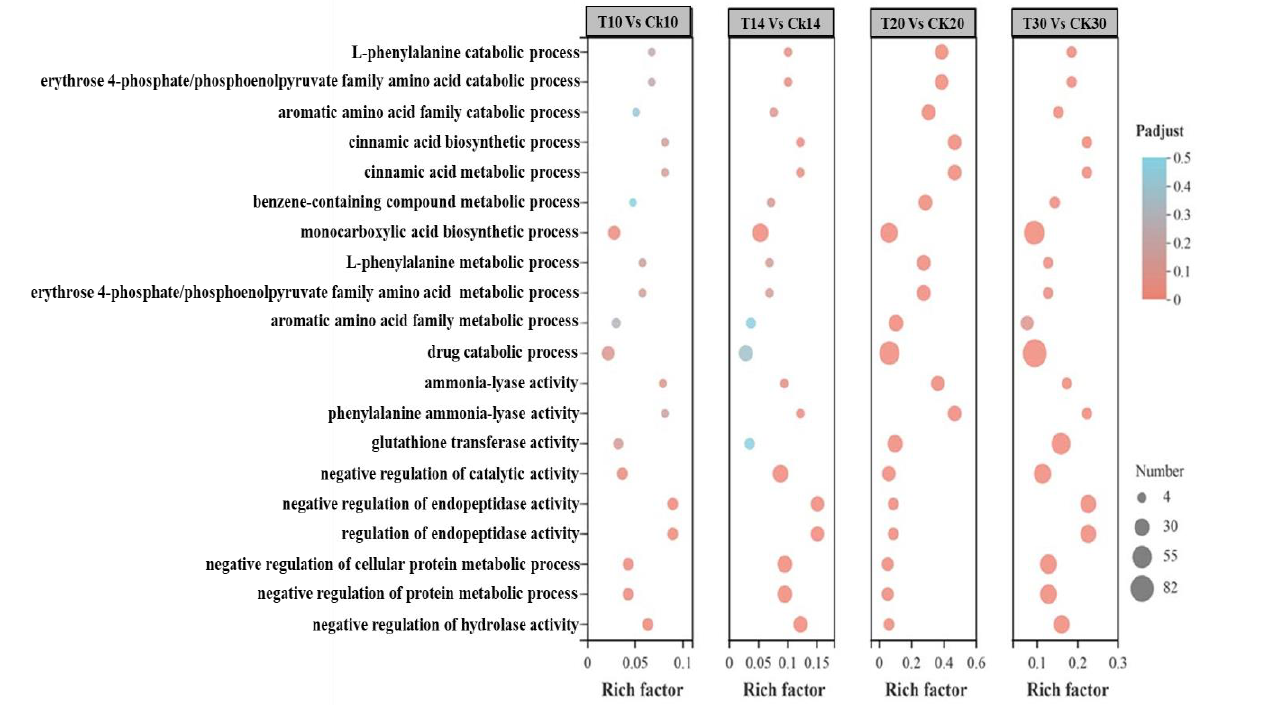
Figure 8. Clusters of GO function classification of DEGs. A total of 1920 DEGs were mapped to 107 KEGG pathways. There were 373, 379, 444, and 203 DEGs for (T10 vs. CK10, T14 vs. CK14, T20 vs. CK20, and T30 vs. CK30), respectively.